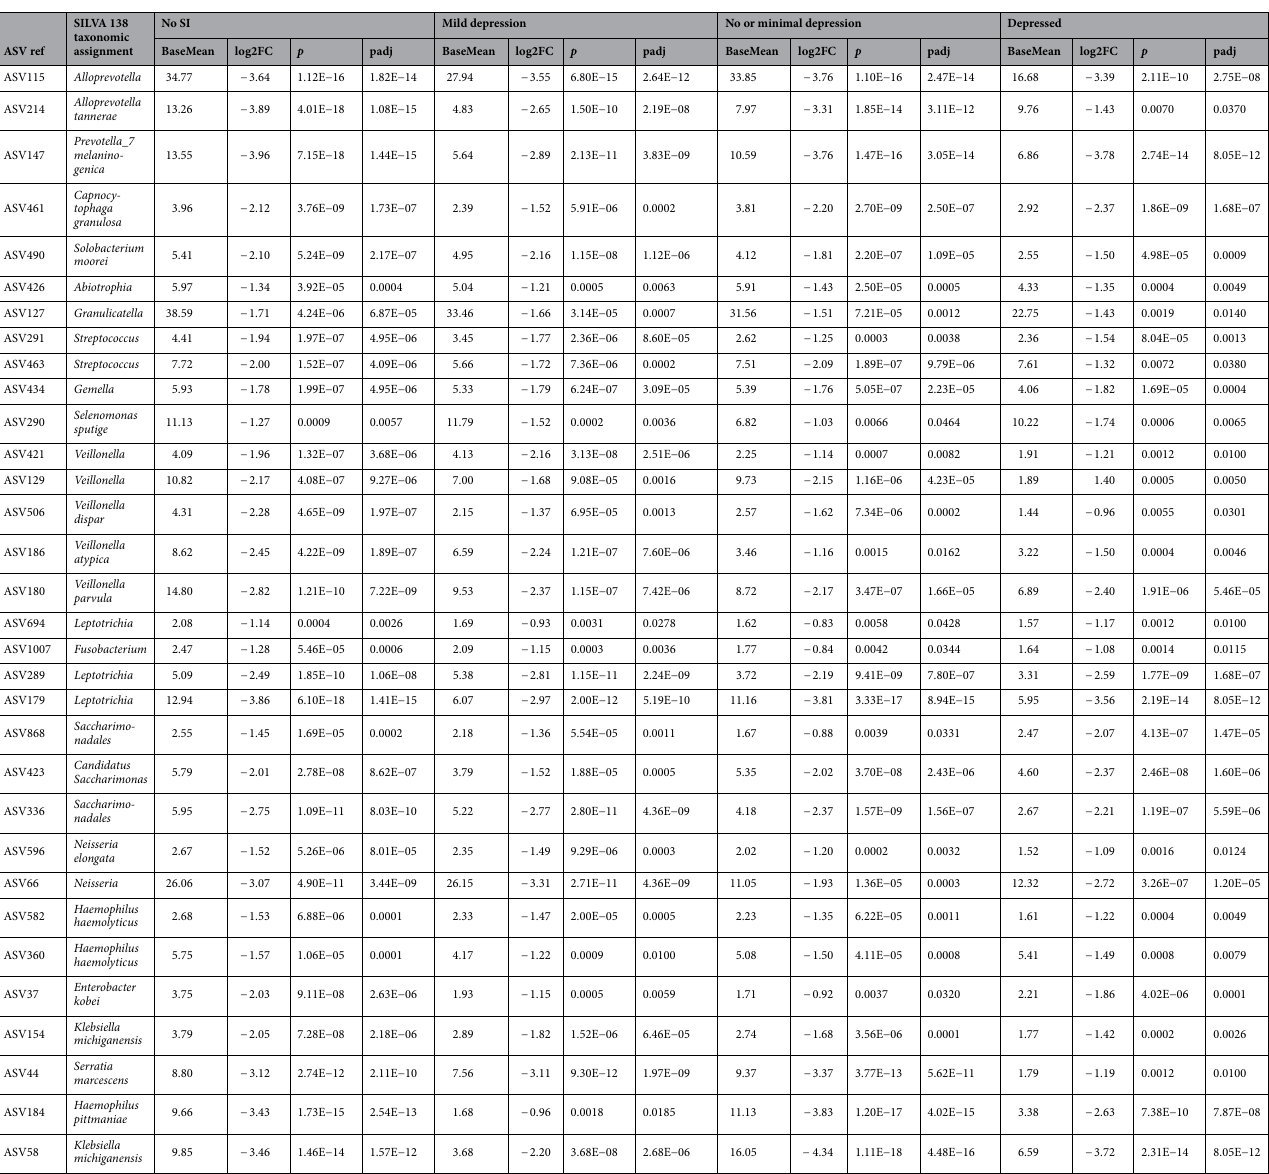
Table 3. Amplicon sequence variants (ASVs) elevated in students with suicidal ideation (SI) or without. DESeq2 statistics for the 75 ASVs that were significantly differentially abundant across all four models described: SI (N = 47) versus No SI (N = 325, with any PHQ-9 total score), Mild depression (N = 128, with PHQ-9 total scores [5–9]), No depression (N = 157, with PHQ-9 total scores [0–4]), or Depressed (N = 40, with PHQ-9 total scores ≥ 10). Normalized base mean counts (baseMean) of the ASV and log2 fold change (log2FC) are provided for each model, and ASVs with |log2FC| ≥ 2 are highlighted in italics (elevated in individuals with SI) or underline (elevated in individuals without SI). p values are provided, both with and without adjustment (padj) for false discovery rates (FDR). Full sequences for all ASVs are provided in Supplementary Table